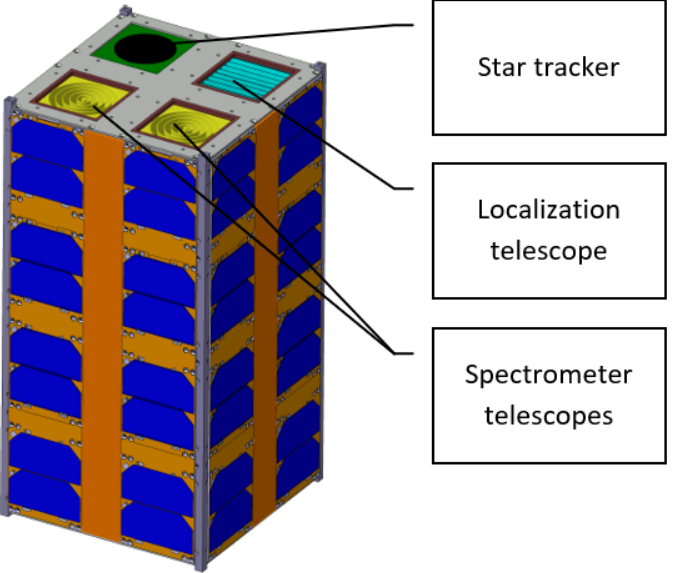
Figure 1. The 16U CubeSat with X-ray telescopes payload concept